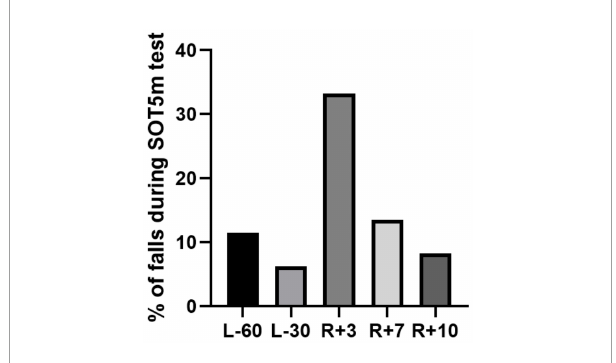
benefit of physical training in microgravity is the well-known fact (Kozlovskaya et al., 2015), but we didn’t find any mentions on comparative studies between RSA and NASA/ESA training programs.